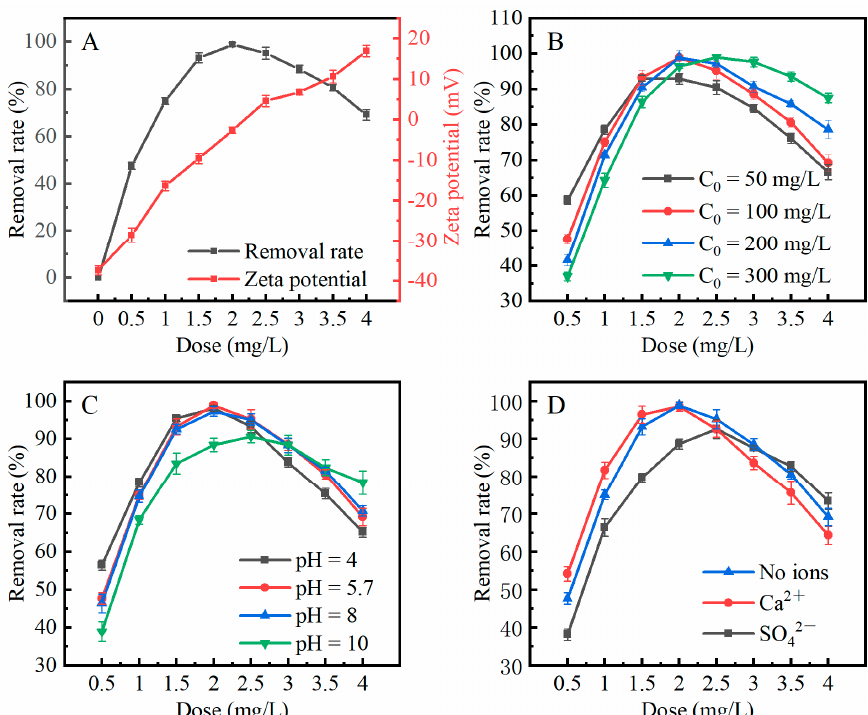
Figure 4. Effects of ( A ) dose, ( B ) initial concentration of the kaolin suspension, ( C ) suspension pH and ( D ) coexisting ions on the removal rate. Error bars represent the standard deviation from three repetitions.